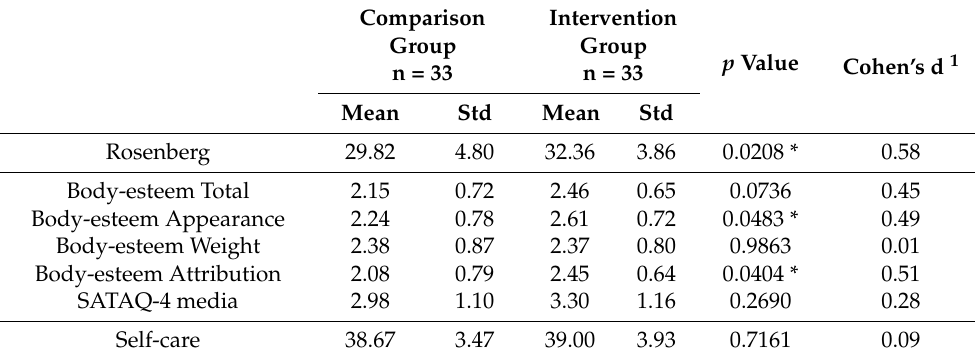
Comparison Intervention Group Group p Value n = 33 n = 33